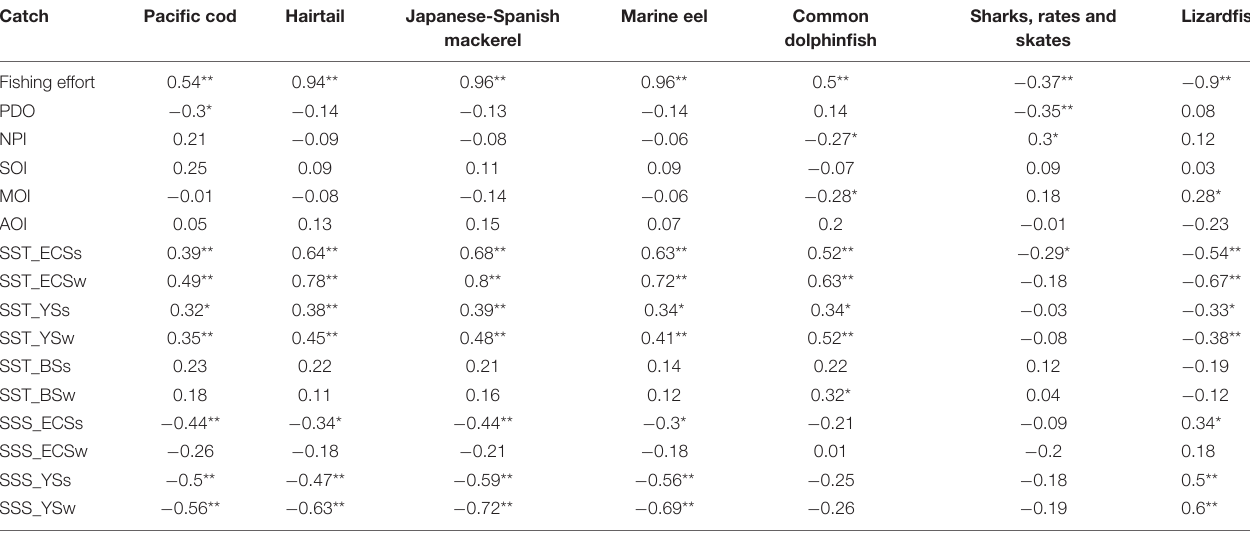
Marine eel Common Sharks, rates and Lizardfish mackerel dolphinfish skates